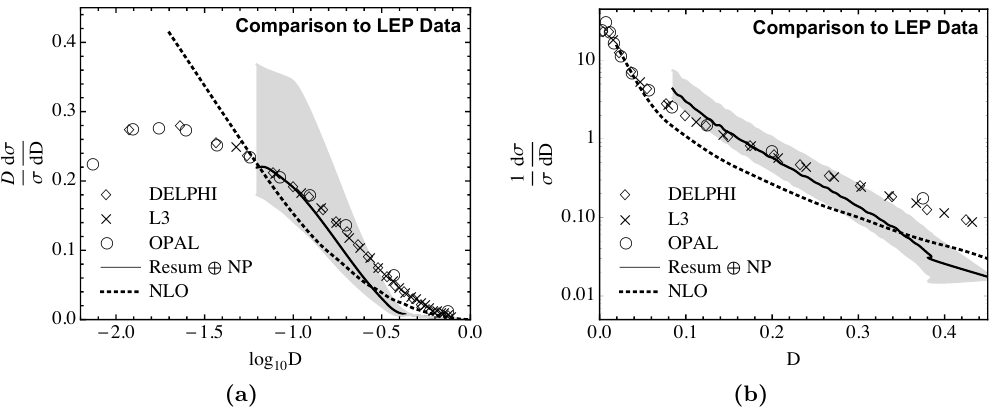
Figure 6. Comparison of our resummed prediction with non-perturbative corrections and the next-to-leading (cid:12)xed order prediction to LEP data on a logarithmic scale (left) and a linear scale (right). DELPHI represents data from ref. [56], L3 represents data from ref. [57], and OPAL represents data from ref. [58]. Uncertainties in the data are comparable in size to the plot markers. The termination of the resummed prediction just below D 0 : 1 is where the non-perturbative ’ corrections become